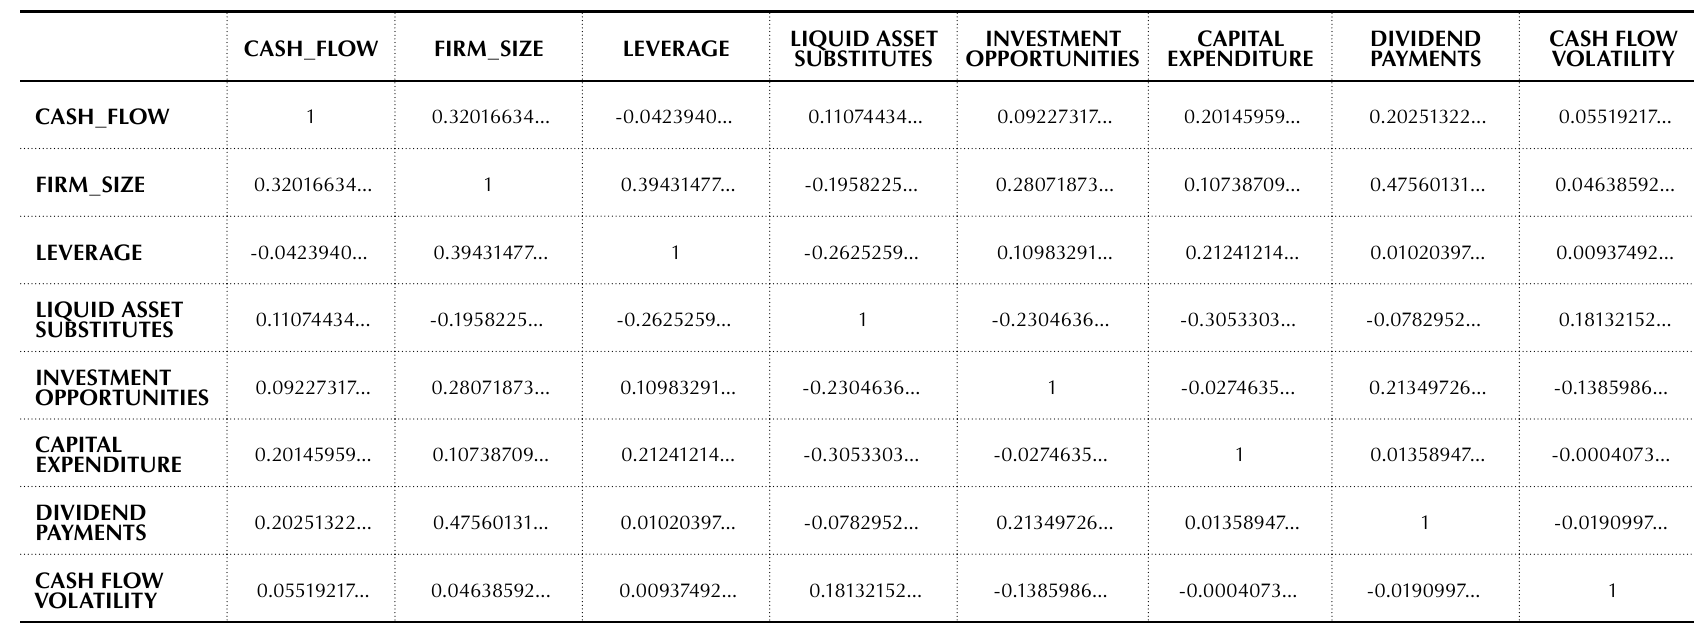
Table 6. Correlation matrix CASH_FLOW FIRM_SIZE LEVERAGE LIQUID ASSET